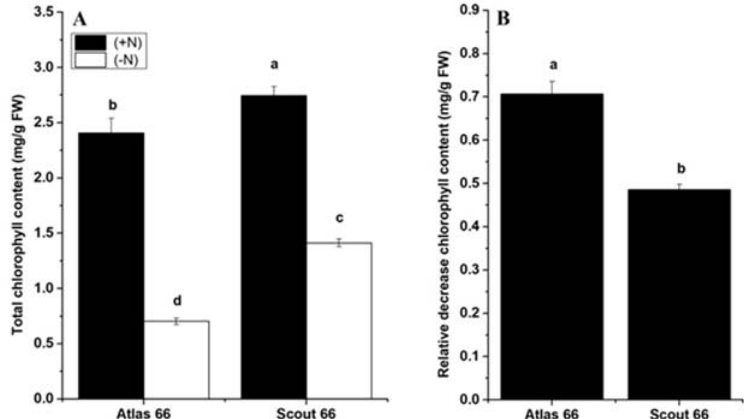
Figure 2. Effect of N deficiency on wheat plant total chlorophyll content ( A ) and the relative decrease of chlorophyll content ( B ). Wheat plants were transferred from N sufficiency to either N sufficient (2 mM) or deficient (50 μ M) conditions for a defined treatment time, and the data presented here were sampled at 14 d from both N levels. Bars represent the mean ± SD ( n = 3). Different small letters indicate statistically significant differences based on LSD tests ( p ≤ 0.05) among the treatments and cultivars.